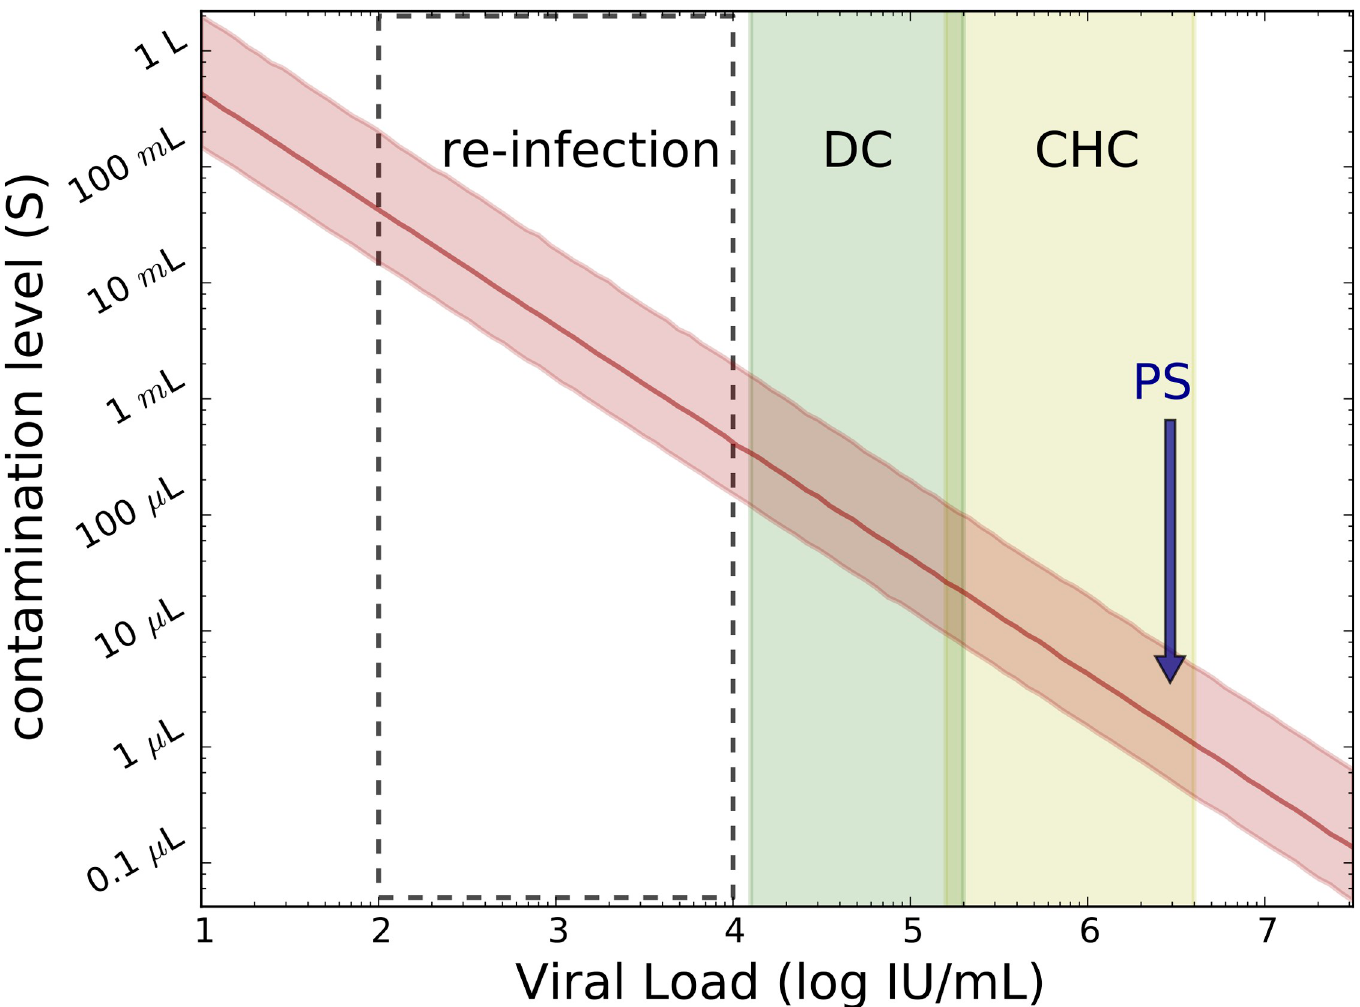
Fig 1. Viral load and ALT kinetics of seven AHC patients managed at SZMC. Open circles: observed HCV viral load above the limit of quantification, LOQ ( > 30 IU/ mL); Red circles: observed HCV < LOQ but still detected; Green squares: observed HCV viral load below the limit of detection. HCV viral loads were assessed using the Abbott RealTime HCV assay (limit of quantification 30